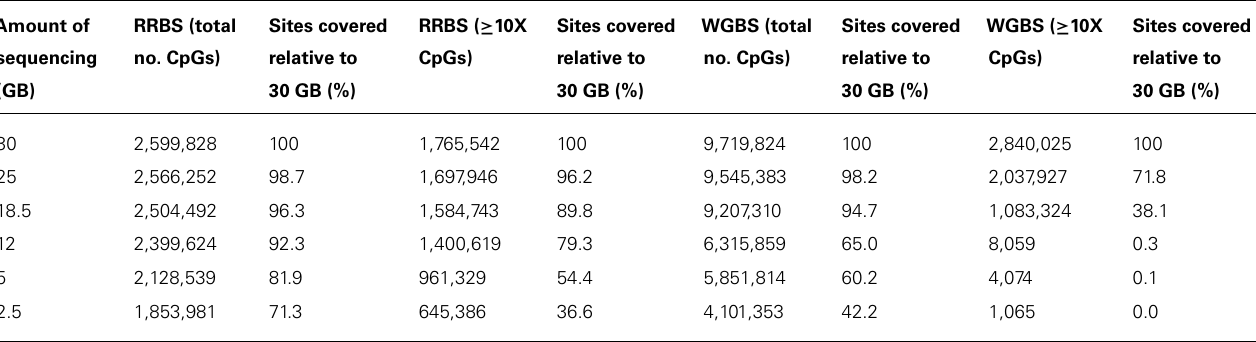
Table 3 | CpG coverage for reduced representation bisulfite sequencing (RRBS) and whole genome bisulfite sequencing (WGBS) when reduced amounts of sequence data are